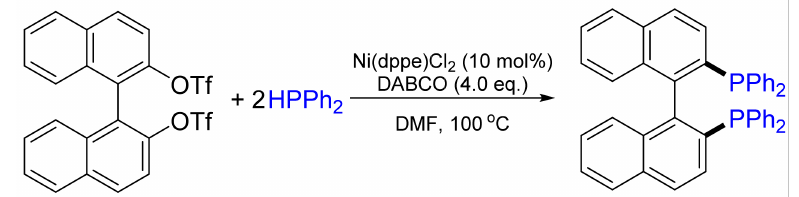
Figure 8. Ni(dppe)Cl 2 -catalyzed BINAP